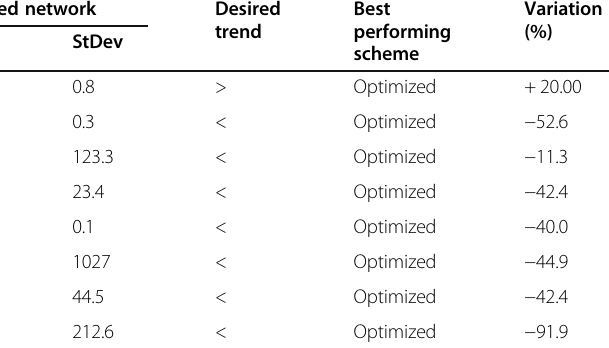
Table 4 Performance Indicators KPI Unit of Existing measure